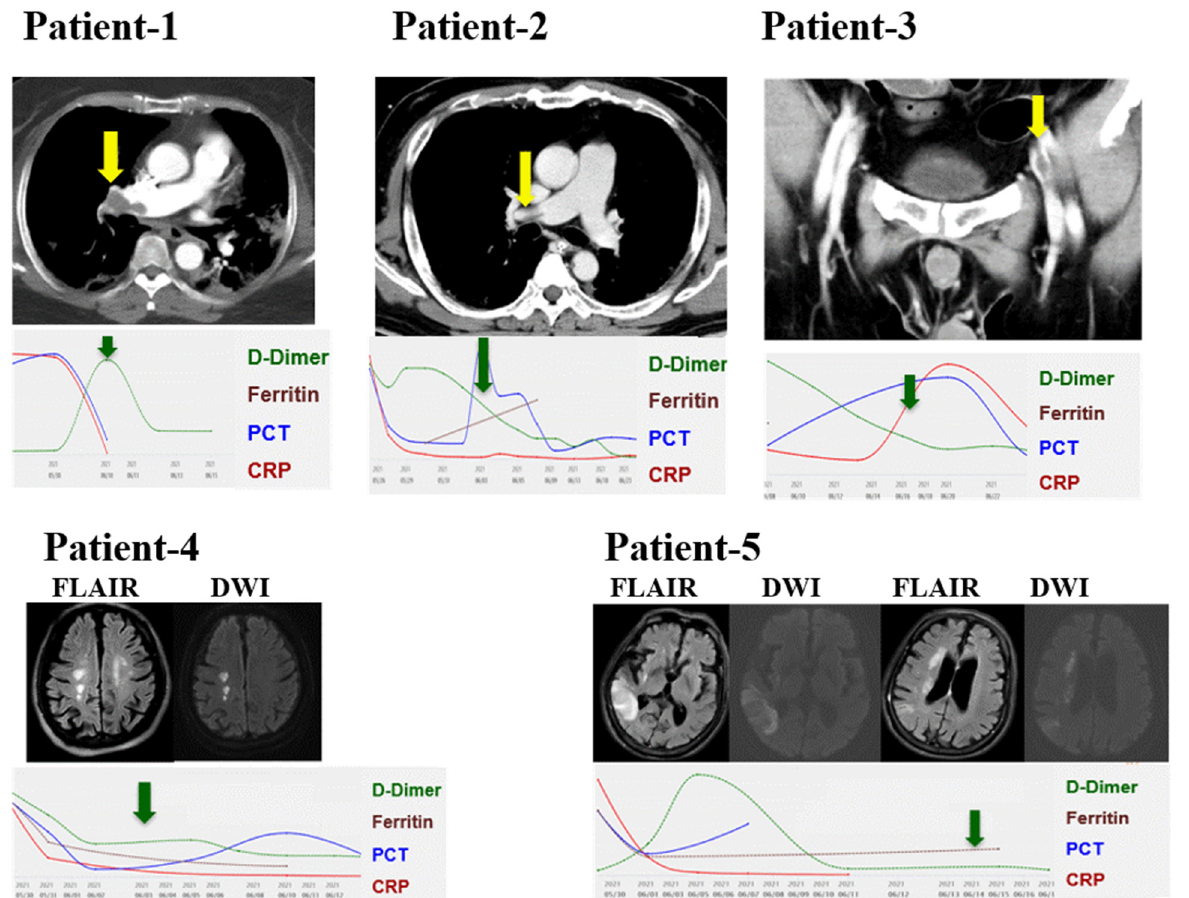
Figure 1. Image and trends of biomarkers among the five patients with thromboembolic events. Pulmonary embolism, patient-1 and patient-2; femoral venous thrombosis, patient-3; acute ischemic stroke, patient-4 and patient-5. Green arrow indicates the date of image survey and yellow arrow represent the presence of thromboembolism. FLAIR, fluid-attenuated inversion recovery; DWI, diffusion-weighted image.